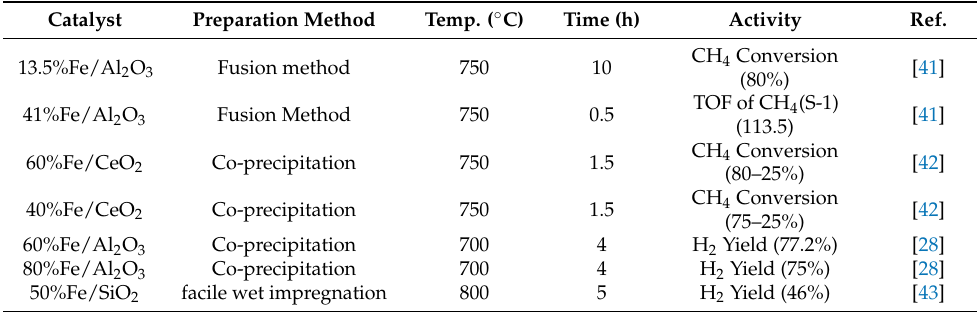
Table 5. The catalytic performance of promising iron monometallic catalysts that were tested in a fixed-bed reactor at different operating conditions collected from different papers